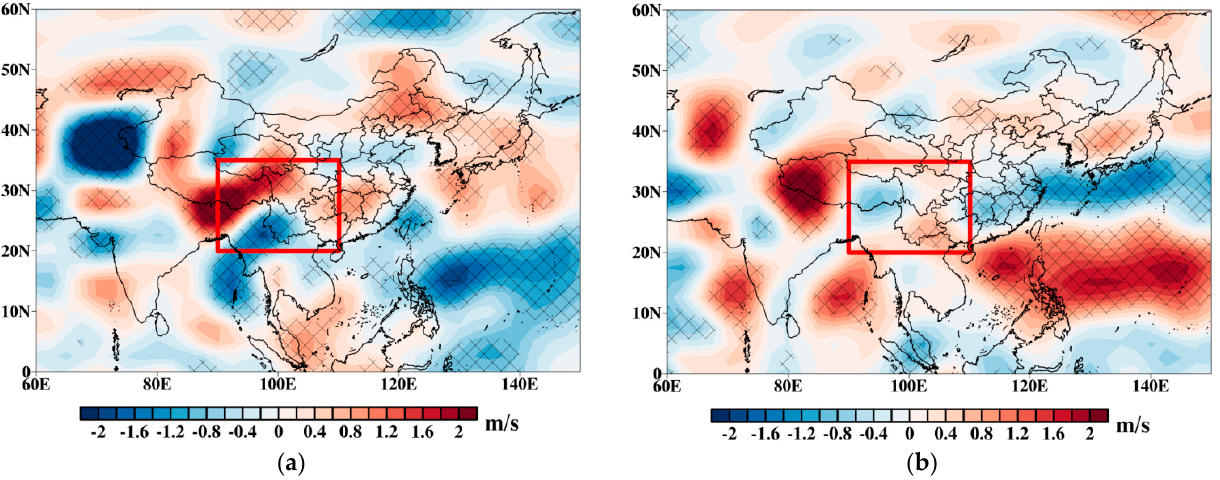
unit: 10 − 6 · Kg · m − 2 · s − 1 ; area in red box is southwest China.) ( a ): Strong years; ( b ): weak years.